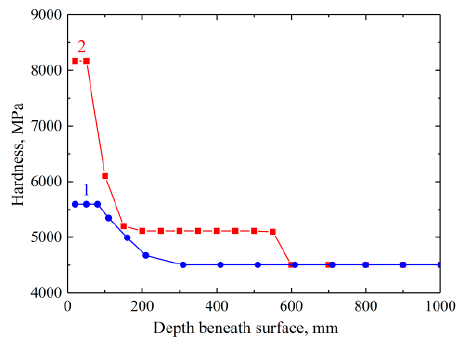
Figure 14. Distribution of Vickers microhardness from the outermost surface to the core of the EBF 3 -fabricated Ti–6Al–4V sample in the as-built state (1) and after continuous electron beam treatment (2).